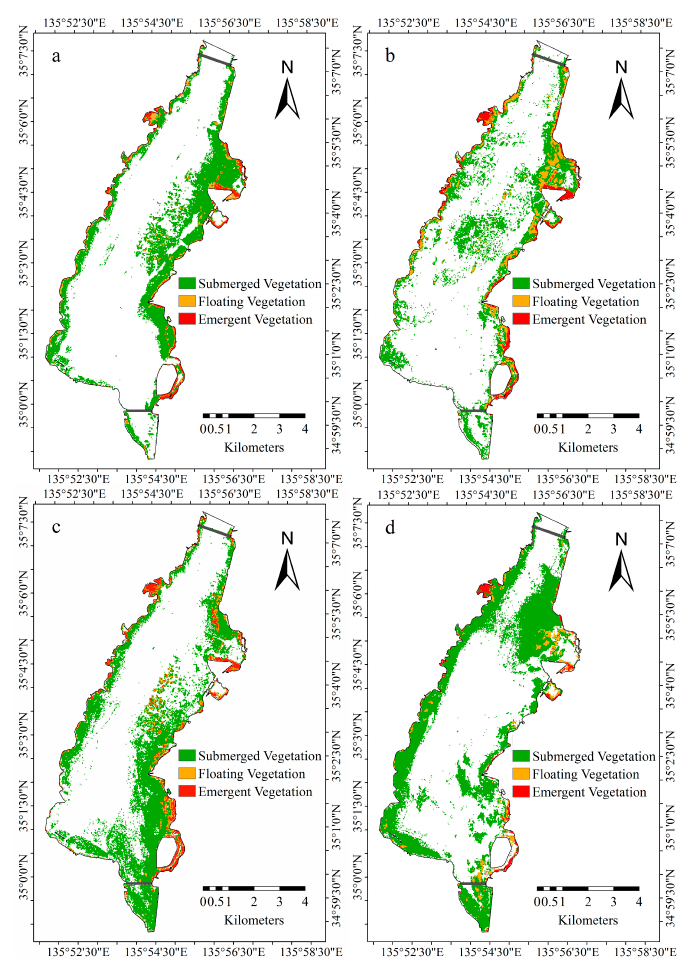
Figure 14. SAV distribution map of the south basin of Lake Biwa (2013-2016): (a) October 2013, (b) September 2014, (c) September 2015, and (d) September 2016.